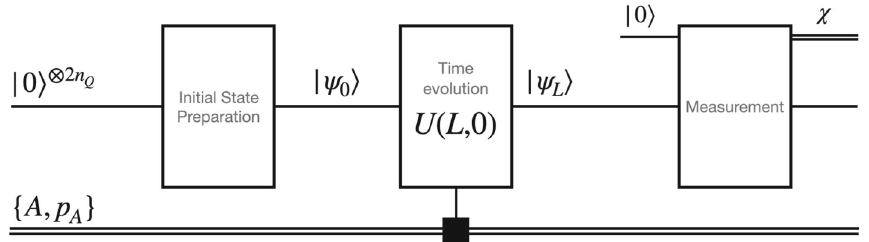
main text for notation). The (cid:2) denotes that the time evolution gates parameters are to be determined from the field